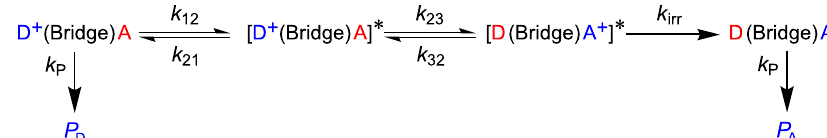
Figure 10. The kinetic scheme adopted to model HT in DNA. D + (Bridge)A and D(Bridge)A + indicate the initial and the finale state, possibly giving rise to oxidation product P D and P A . [D + (Bridge)A]* and [D(Bridge)A + ]* denote the ensembles of structures in which the hole donor and acceptor are in vibronic resonance with each other, so that k 23 = k 32 . k 21 = k irr and k P have been taken from experimental data; k 23 has been computed by resolving the time dependent Schrödinger equation; k 12 is an adjustable parameter to be inferred by comparing computed and experimental product yield